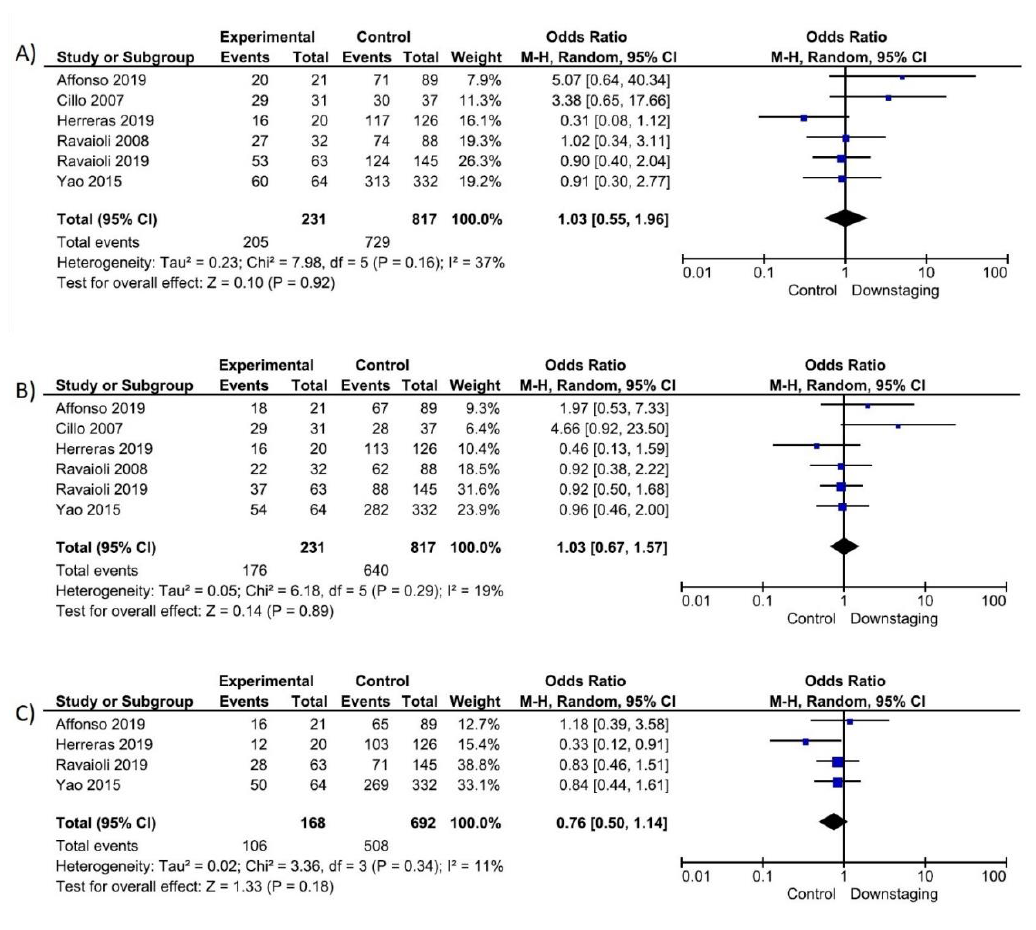
Figure 4. Question 1: Forrest plot post-LT survival: ( A ) 1y-overall survival; ( B ) 3y-overall survival; ( C ) 5y-overall survival.